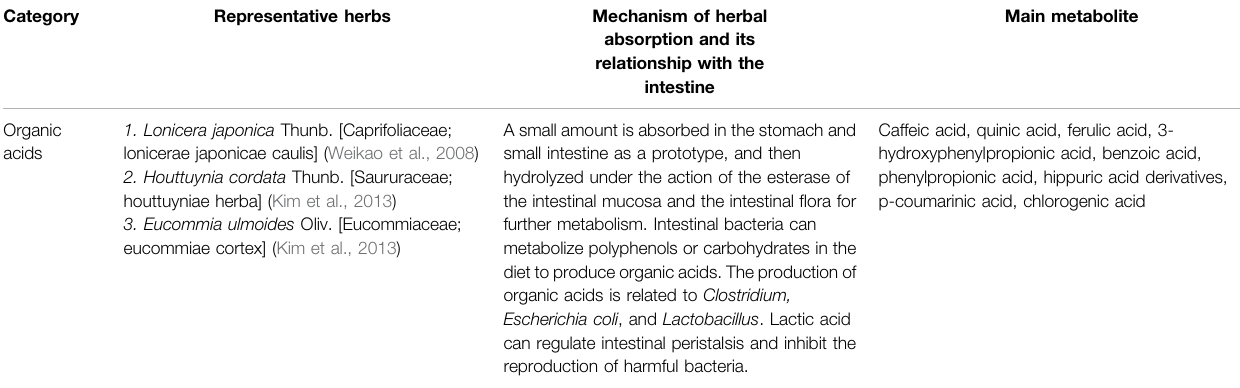
TABLE 1 | ( Continued ) The interaction between the effective ingredients of traditional Chinese medicine and the intestinal fl